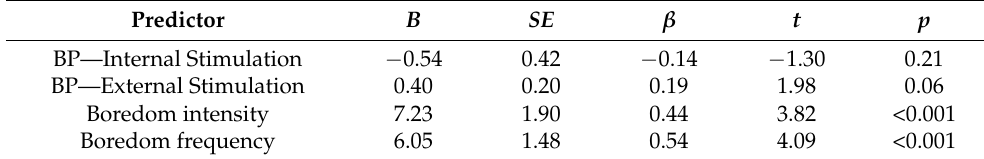
Table 2. Regression analysis of the association between boredom duration and other boredom experiences.